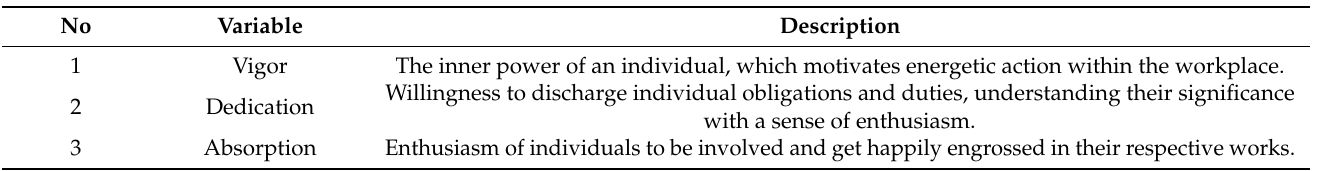
Table 3. Formative variables of work